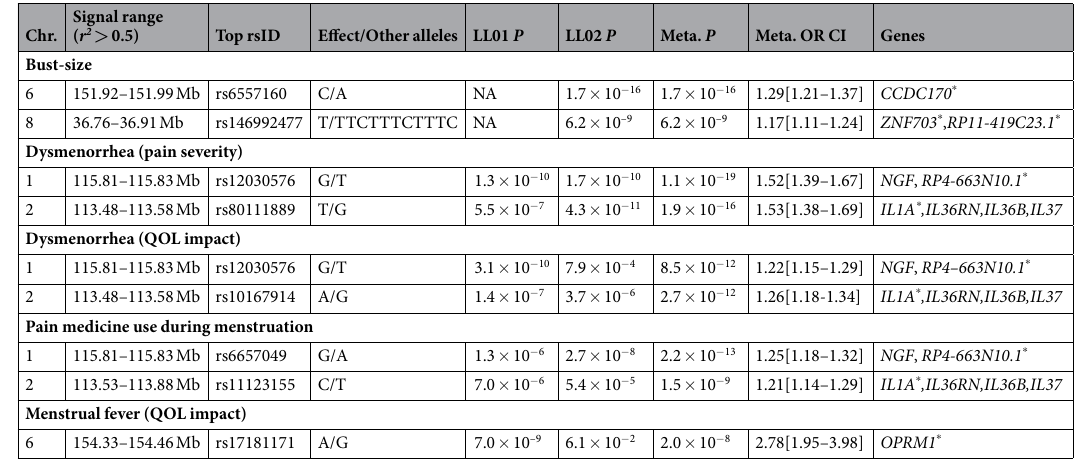
Table 1. Summary of significant loci for gynecology-related phenotypes. * Strong support for GWAS/eQTL signal colocalization/pleitropy. Marks for secondary dysmenorrhea phenotypes refer to results of primary dysmenorrhea